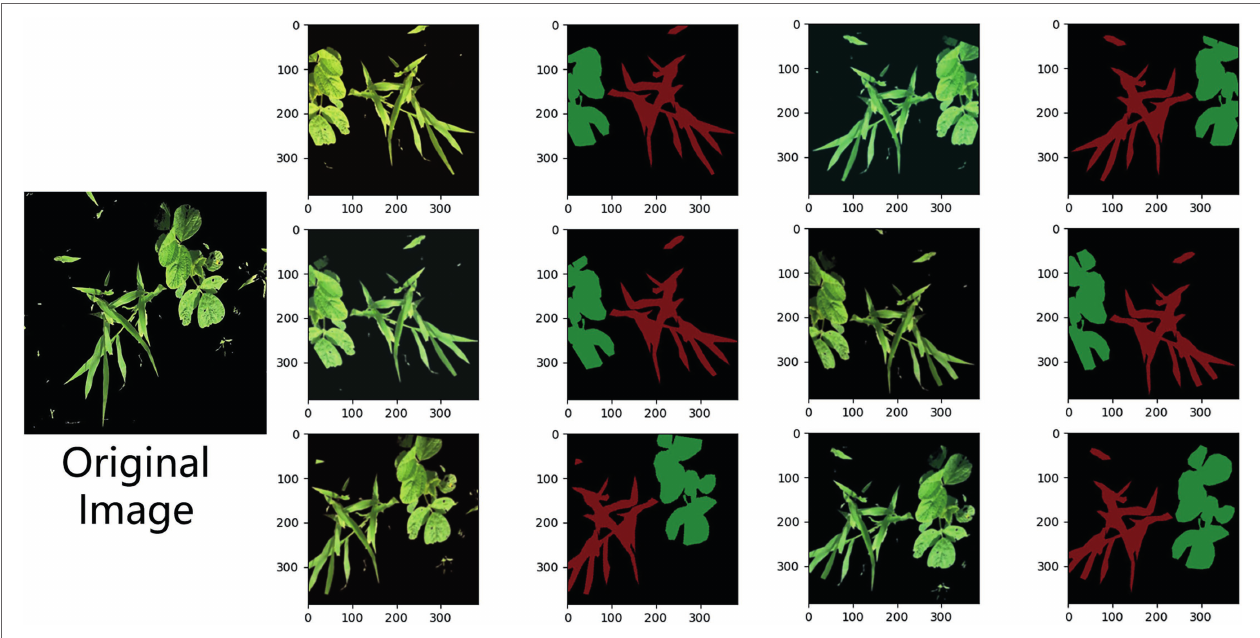
FIGURE 8 | Data augmentation during